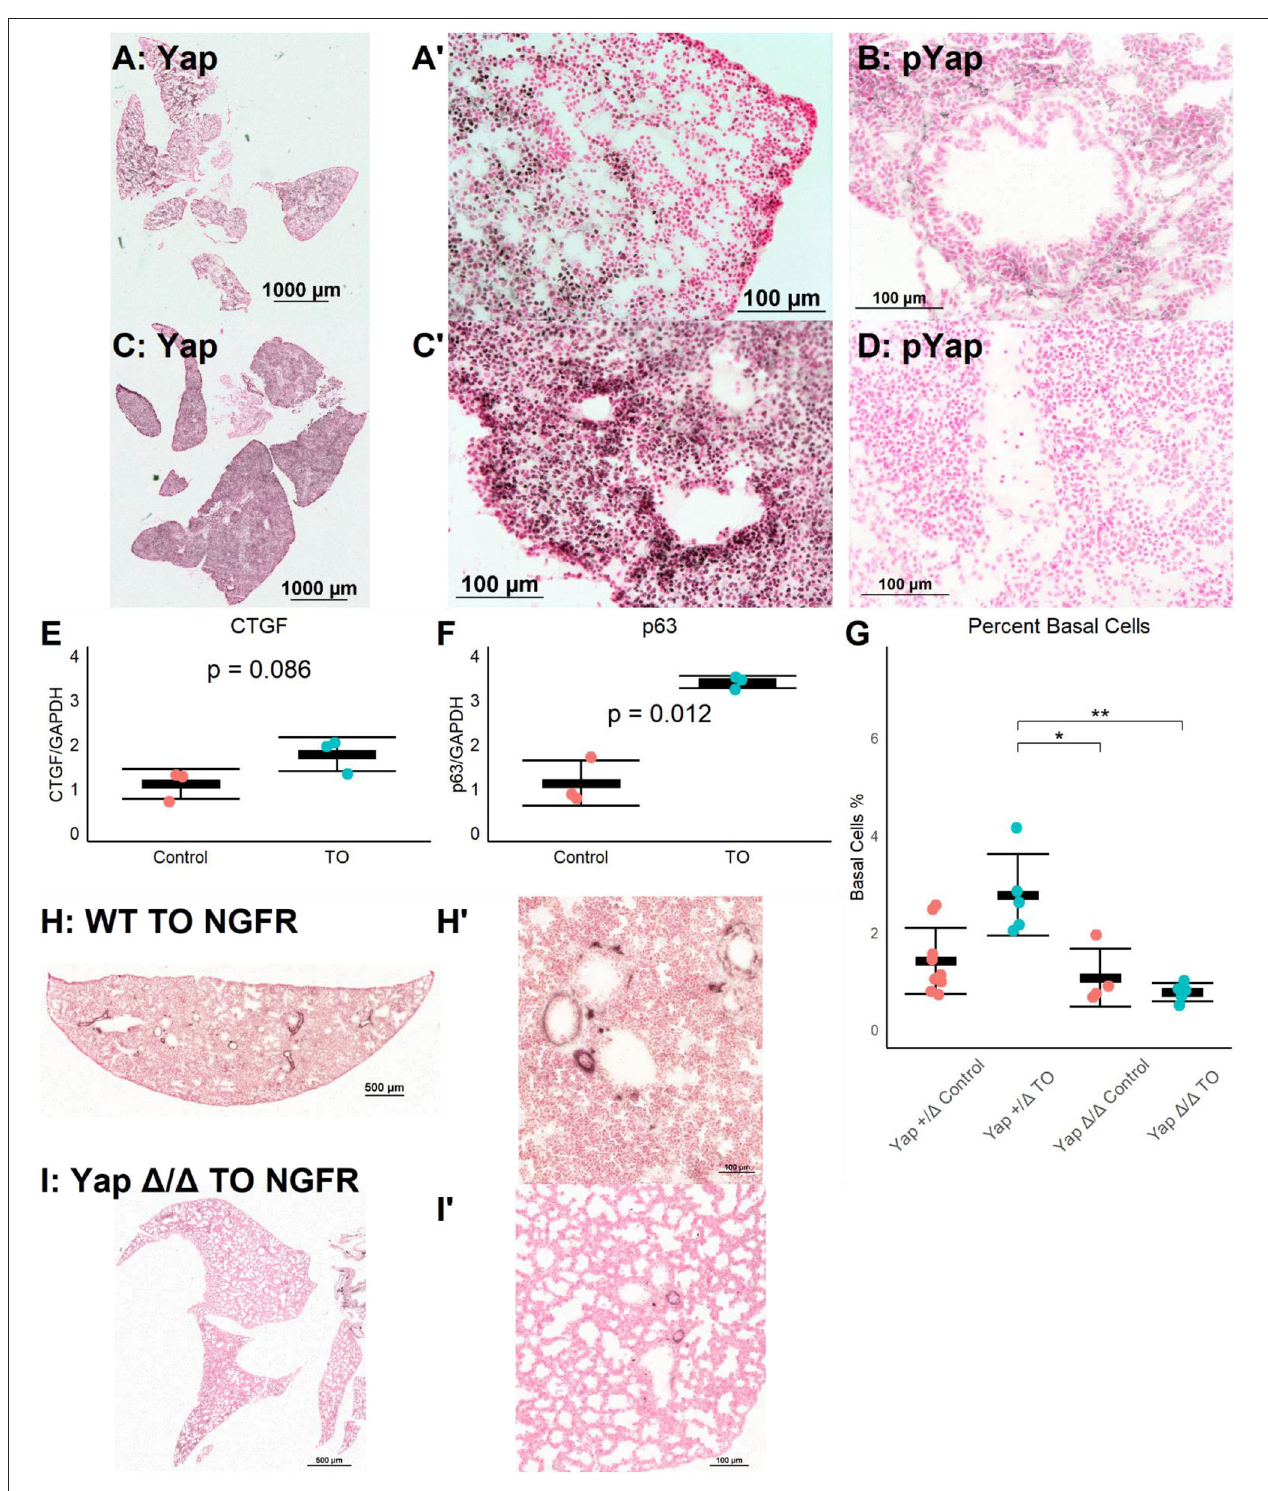
FIGURE 3 | Increased lung epithelial Yap signaling is responsible for basal cell expansion. (A,B) In control E18.5 fetuses, non-phosphorylated (nuclear, active) Yap is present in small clusters of distal lung cells (A) and phosphorylated (cytosolic, non-active) Yap is widely present (B) . (C) In E18.5 TO lung, non-phosphorylated Yap is present more homogenously throughout the lung and can be detected more in nuclei than in control, with denser abundance of nuclear-Yap-containing cells round airways. (D) In TO lung, phosphorylated Yap is less abundant than in control lung. (E,F) PCR of lung homogenates showed increased levels of connective